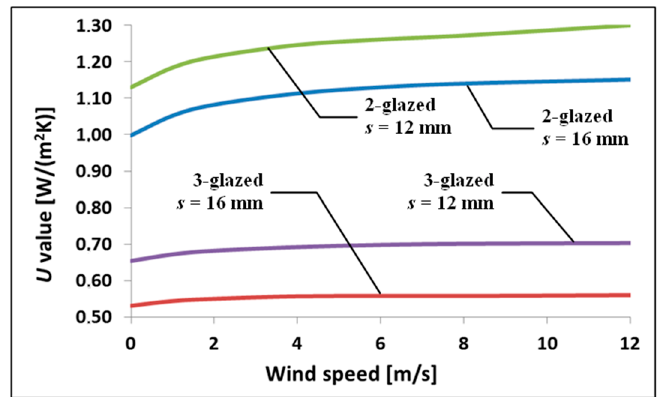
Figure 7. Influence of wind velocity on the U g - value of sample insulating glass units.